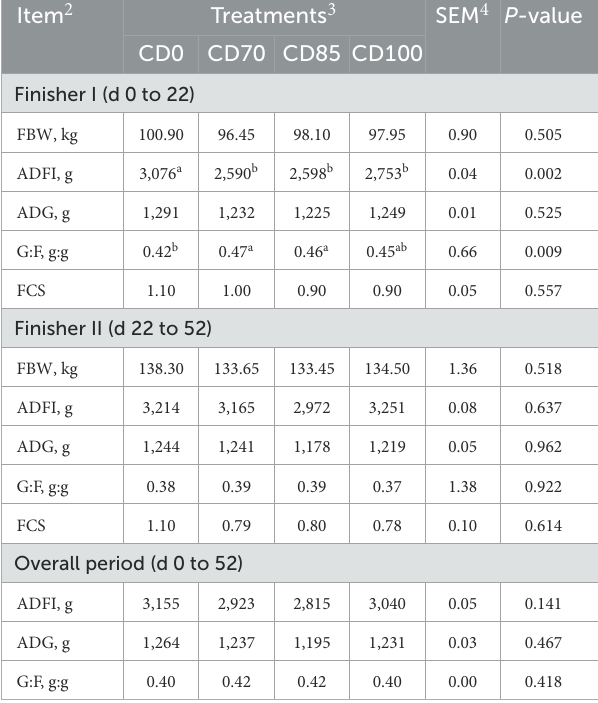
a,b MeansfollowedbydifferentlowercaselettersonthesamerowdifferbyTukey posthoc test (P < 0.05). 1 Dataaremeansof10pensreplicatespertreatmentand1pigperpenasanexperimentalunit. 2 IBW: initial body weight, FBW: final body weight, ADFI: average daily feed intake, ADG: averagedailygain,G:F:gaintofeedratio,FCS:fecalconsistencyscore(score0: < 70%normal feces);score1:70–75%softfeces,score2:75–80%semi-solidfeces,andscore3: > 80%liquid